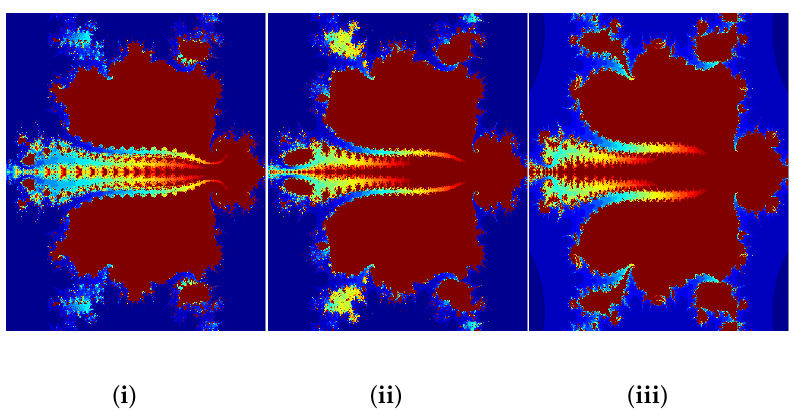
Figure 3. Cubic Julia sets in ( i ) Noor-orbit; ( ii ) Ishikawa-orbit; ( iii ) Mann-orbit. The parameters with quintic ( n = 5) used in Figure 4 are as following in Table 4: Table 4. The parameters used in Figure 4.